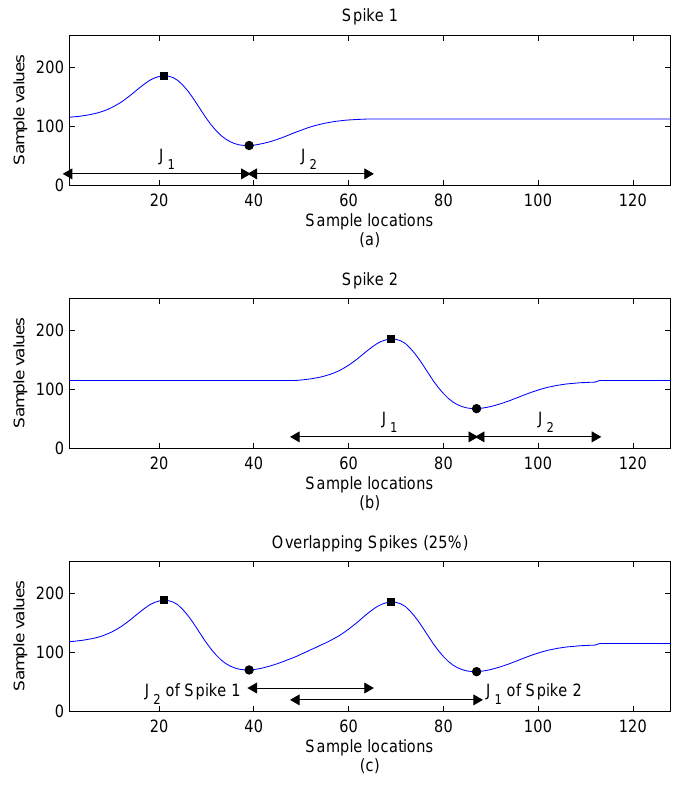
Figure 3. An example of two spikes overlapping by 25% for feature extraction. ( a ) Original Spike 1; ( b ) original Spike 2; ( c ) resulting waveform after the combination of the two